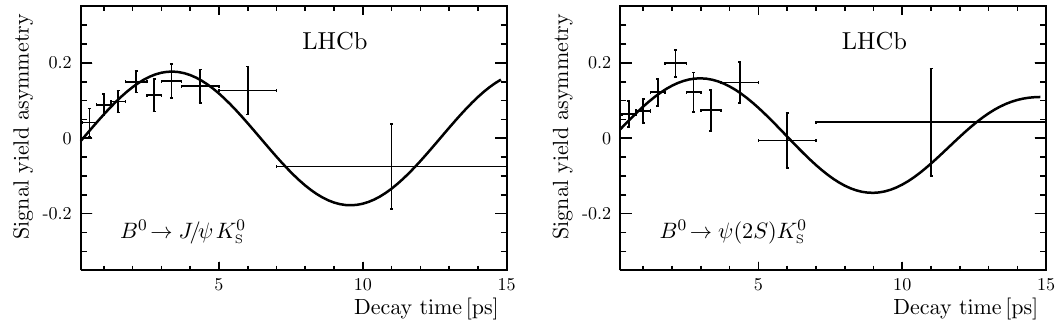
Figure 3 . Signal yield asymmetries ( N B 0 ! J= K 0 and (right) B 0 ! (2 S ) K 0 S with a B 0 ( B 0 ) (cid:13)avour tag. The solid curves are the projections of the PDF with the combined (cid:13)avour tagging decision.